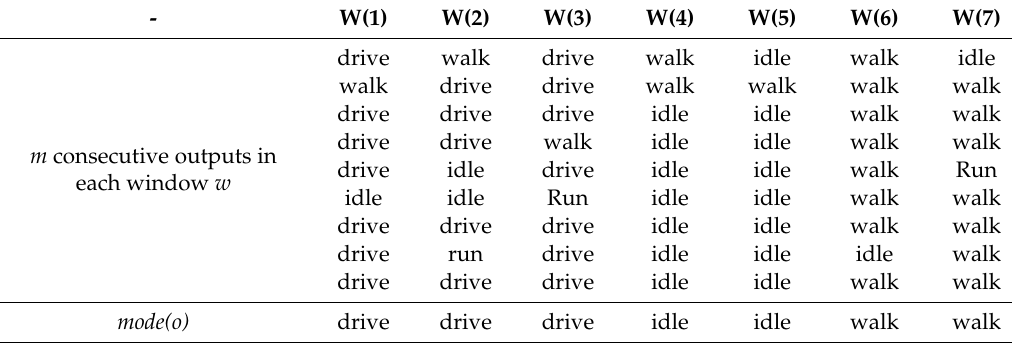
Table 3. Example of finding the mode ( o ) of context prediction (CP) in each rolling window.